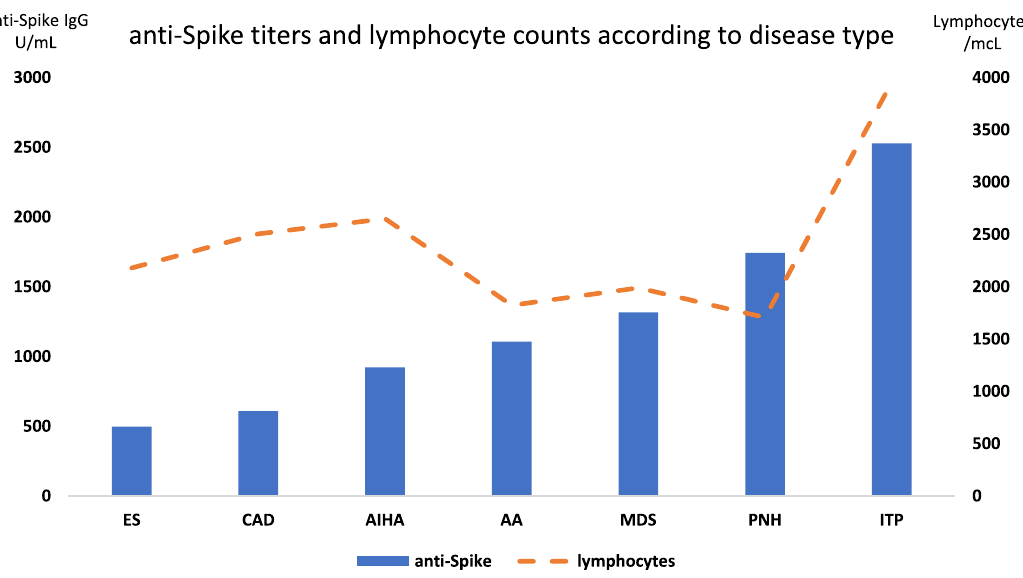
Figure 3. Anti-Spike titers and lymphocyte counts divided according to the various diseases. ES Evans syndrome; CAD cold agglutinin disease; AIHA autoimmune hemolytic anemia; AA aplastic anemia; MDS myelodysplastic syndromes; PNH paroxysmal nocturnal hemoglobinuria; ITP immune